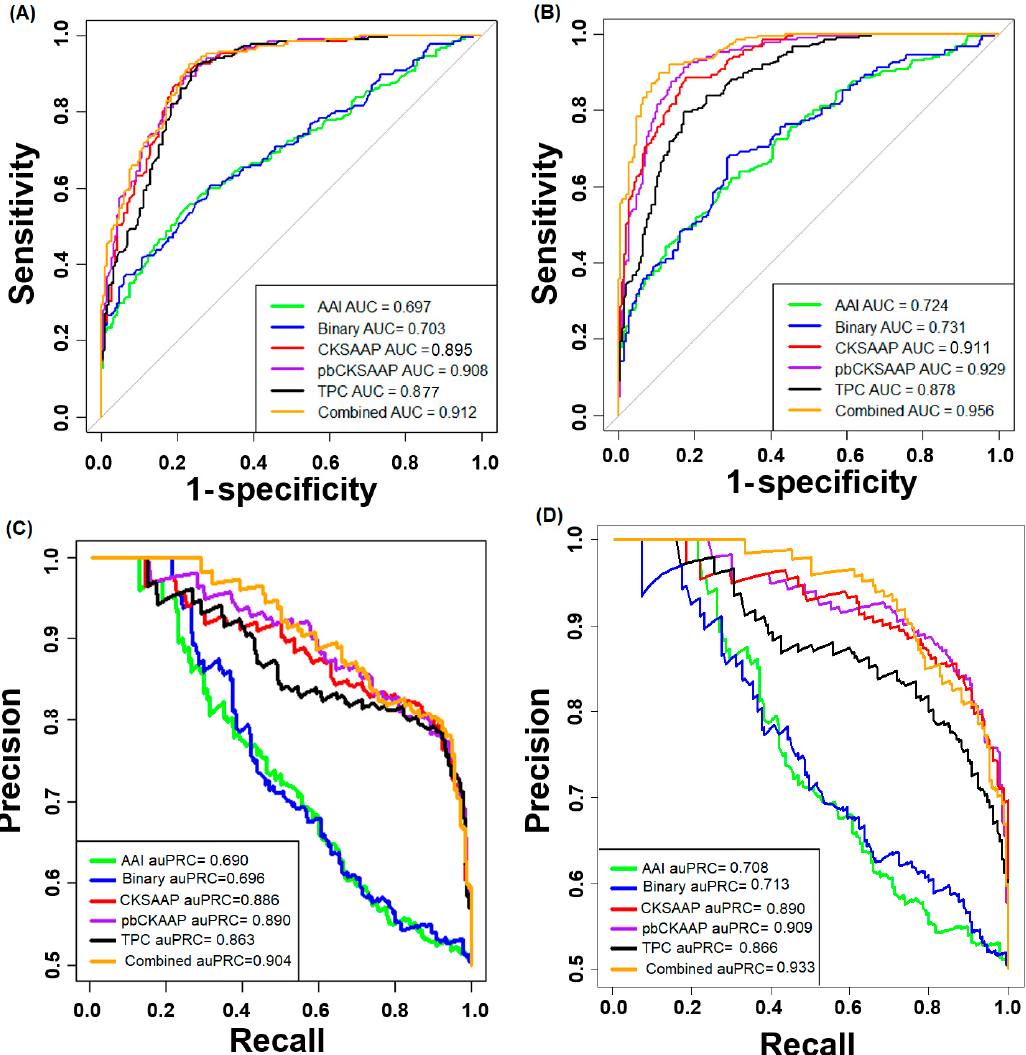
Figure 3. Prediction performance of the single encoding-employing models and their combined model (PUP-Fuse) on the training datasets. ( A ) No feature selection is employed. ( B ) Feature selection is used. ( C ) Precision vs. recall curve without feature selection. ( D ) Precision vs. recall curve with feature selection.